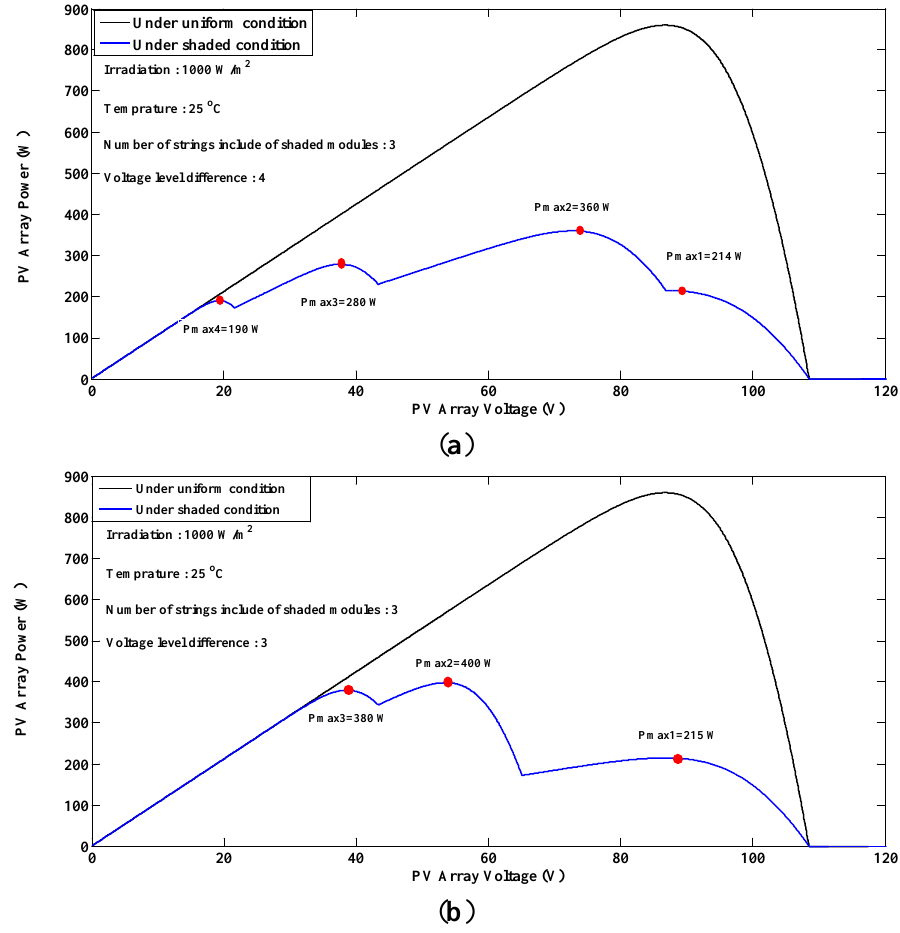
Figure 12. P - V curves for ( a ) first scenario of shadowing and ( b ) second scenario of